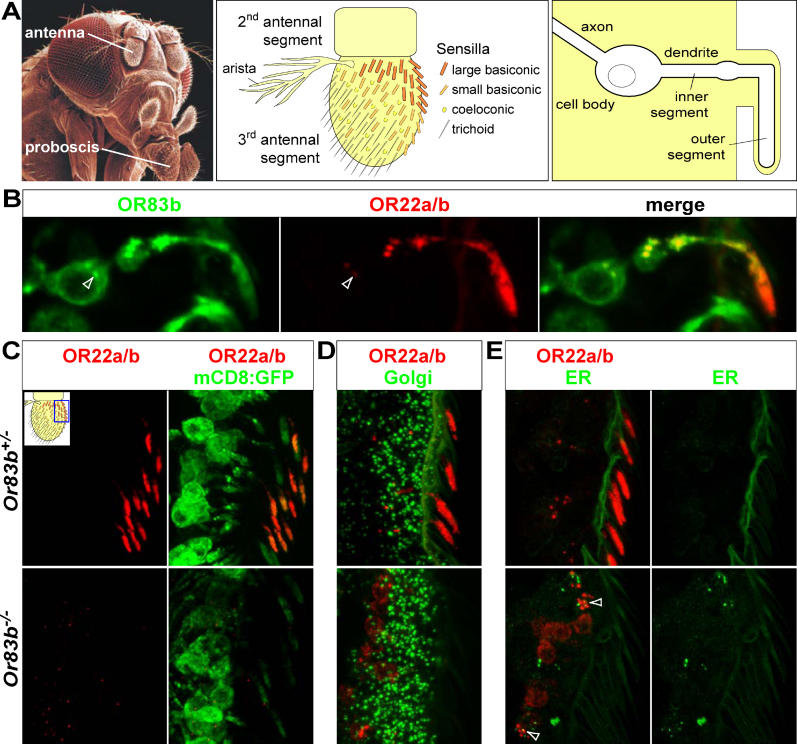
OR83b Is Essential for OR Membrane Trafficking(A) The Drosophila olfactory system. Left panel: false-colored scanning electron micrograph image of a Drosophila head illustrating the major olfactory (antenna) and gustatory (proboscis) organs (photo: Jürgen Berger, Max Planck Institute for Developmental Biology, Tübingen, Germany). Center panel: schematic of olfactory sensilla distribution on the third antennal segment. Right panel: schematic of OSN anatomy.(B) Immunostaining for OR83b (green) and OR22a/b (red) in antennal sections of a wild-type (yw) animal. Arrowheads mark enrichment of perinuclear OR83b that co-localize with the trace amount of OR22a/b present in the cell body.(C) Immunostaining for OR22a/b (red) and mCD8:GFP (α-GFP, green) in antennal sections of control heterozygous (Or83b1/+, top row) and homozygous (Or83b1/Or83b2, bottom row) Or83b null-mutant animals. The position of the field of view, in this and subsequent figures, is illustrated by the blue square in the antennal schematic (inset in upper left panel). Images of control and mutant samples were taken at identical confocal settings to permit comparison of signal intensities. Therefore, levels of OR22a/b are lower in (C) than in (D and E), in which confocal settings have been adjusted to permit visualization of OR22a/b in Or83b mutants.(D) Immunostaining for OR22a/b (red) and Golgi (α-Golgi, green) in antennal sections of control heterozygous (top panel) and homozygous (bottom panel) Or83b null-mutant animals.(E) Immunostaining for OR22a/b (red) and ER (α-KDEL, green) in antennal sections of heterozygous control (top panel) and homozygous (bottom panel) Or83b null-mutant animals. Mislocalized OR22a/b and KDEL accumulations overlap in the mutant (arrowheads in lower left panel). Autofluorescence of the antennal cuticle is visible in the green channel at the base of the sensilla. In (D and E), confocal settings of the red channel were adjusted to permit clear visualization of the weaker OR22a/b signal in Or83b mutants.